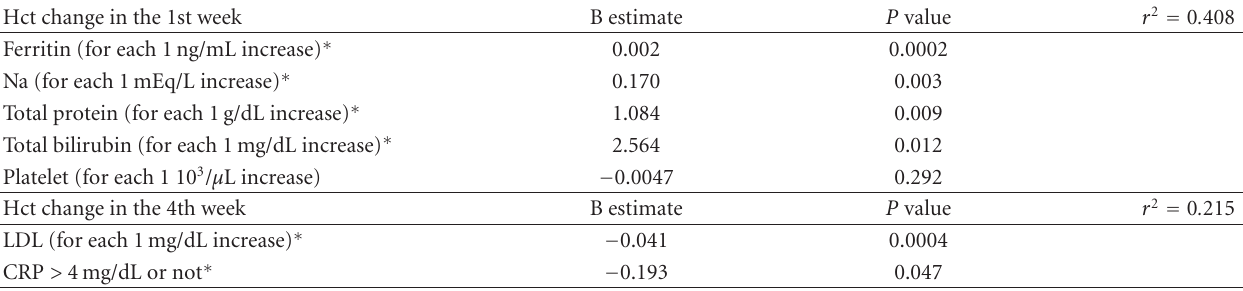
Table 3: The multivariate linear regression model of factors associated with Hct change in HD patients after treatment of CERA in the 1st and 4th week